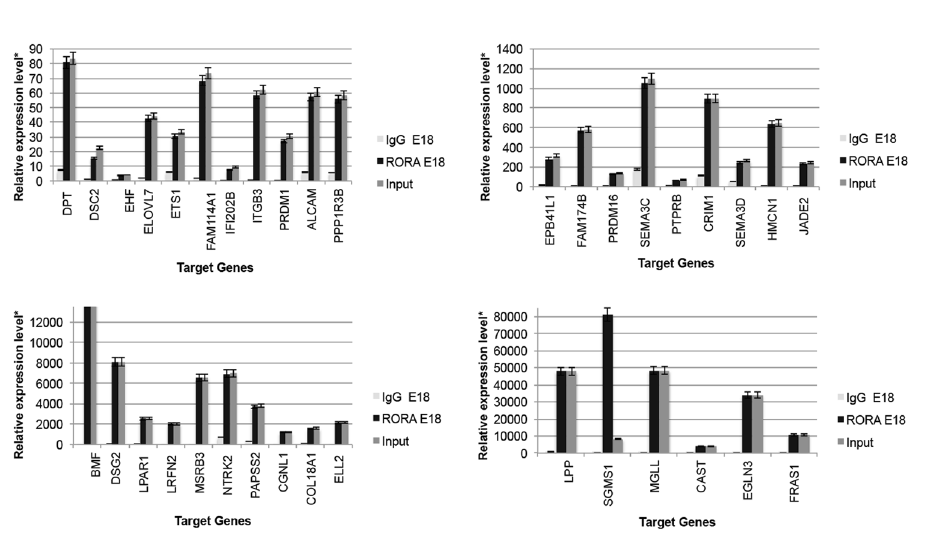
Figure 4. Chromatin IP (chIP) quantitative real time PCR (chIP-qRT-PCR) of gene targets for RORA at E18. Input (positive control), RORA-chIP, and immunoglobulin G (IgG) negative control. * Relative expression is calculated as molecules/1000 molecules β -actin. Standard errors are indicated for each gene. All genes had a minimum significance of p <